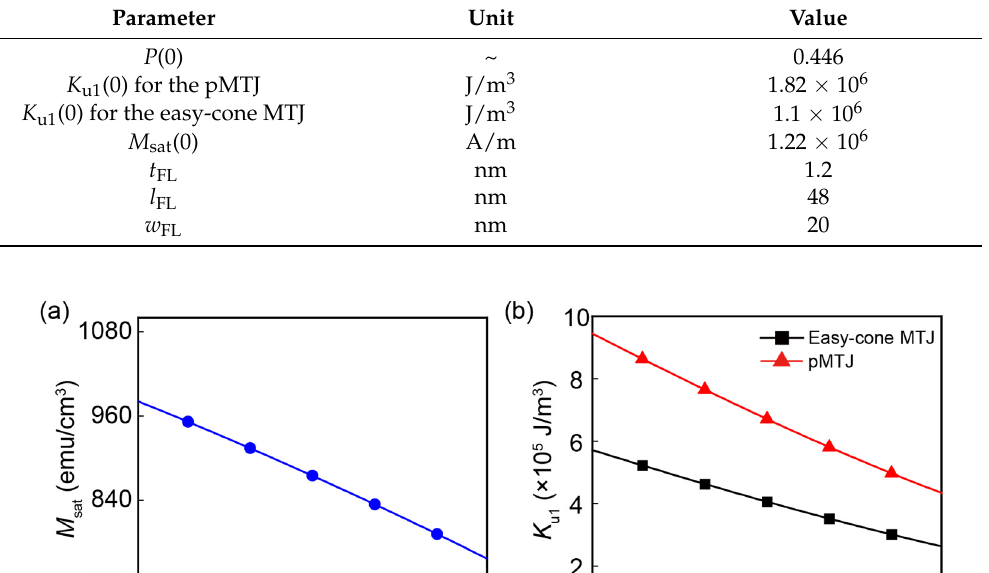
Table 1. Parameters of the system. Parameter